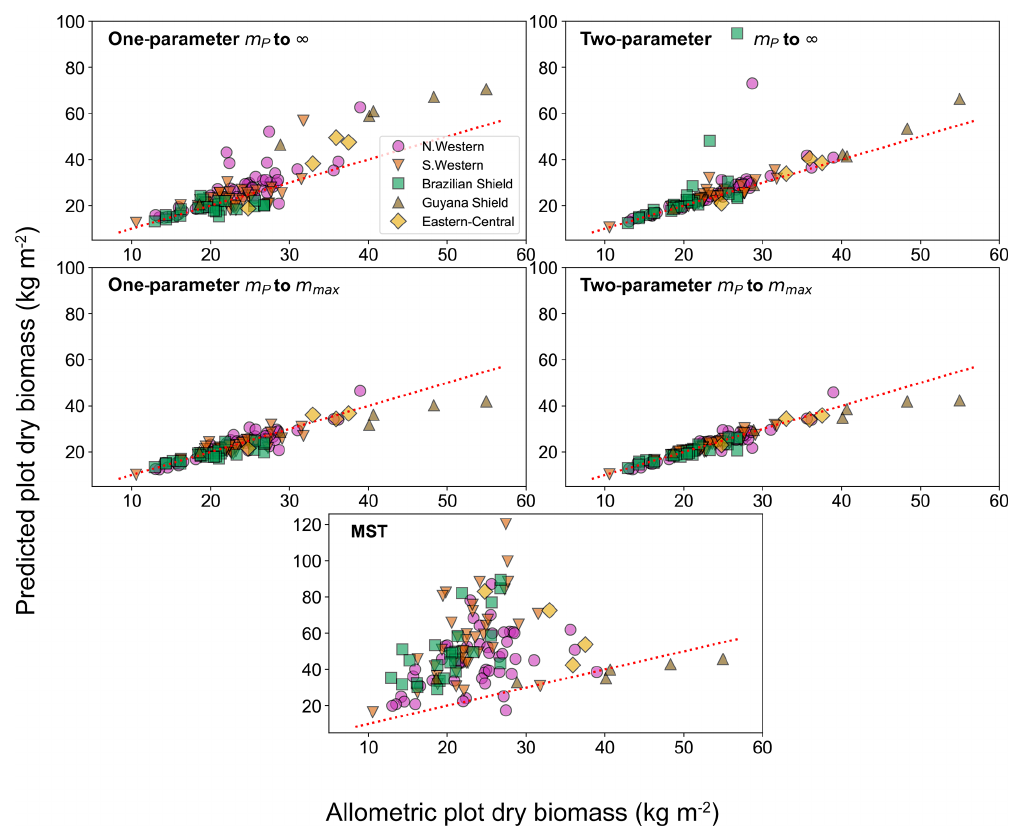
Figure 9. Comparison of the biomass density prediction based on the size-distribution fits to the mass data and to the allometric biomass density in each of the 124 forest plots. Results are plotted for both the one- and two-parameter fits and for both the assumption of infinite and finite maximum tree size. The finite tree size case is limited to the largest tree mass m max in each forest plot. The red dotted line illustrates the line of a perfect one-to-one relationship (i.e. theory matching the data